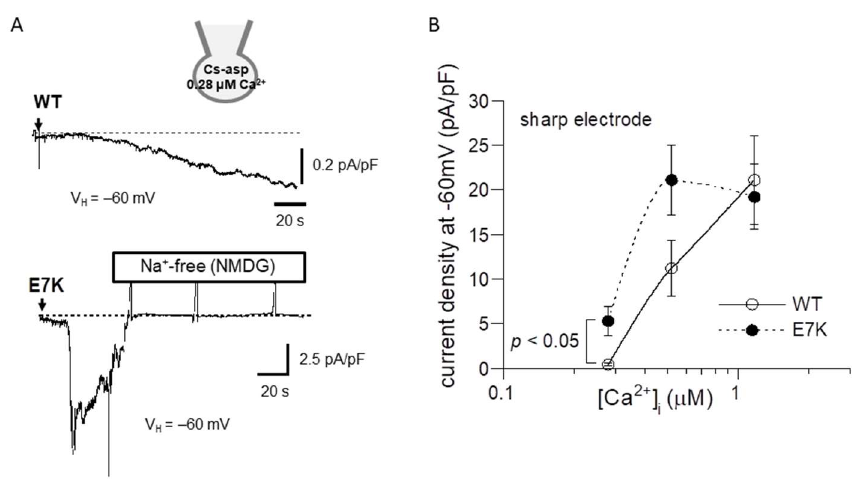
Figure 5. Ca 2+ -dependent activation curves for wild-type and E7K-TRPM4 currents. Internal solutions containing three different [Ca 2+ ] i were introduced via sharp thin patch electrodes into the cell by breaking the giga-sealed membrane at a holding potential of − 60 mV. ( A ) representative traces of 0.52 µ M [Ca 2+ ] i -induced currents from HEK293 cells expressing either wild-type (upper) or E7K-mutant (lower) TRPM4 channels. The arrows indicate the timepoints of ‘break-in’. Vertical positive deflections in the figure show the membrane currents evoked by ramp voltages. ( B ) the relationships between the TRPM4 current amplitude (at − 60 mV) and intracellularly perfused [Ca 2+ ] i . Open and filled circles represent wild-type and E7K-mutant TRPM4 channels. n = 4–12. Each condition was tested independently. Only the data at the same [Ca 2+ ] i was compared by unpaired t -test. *, **: p < 0.05 and 0.005.